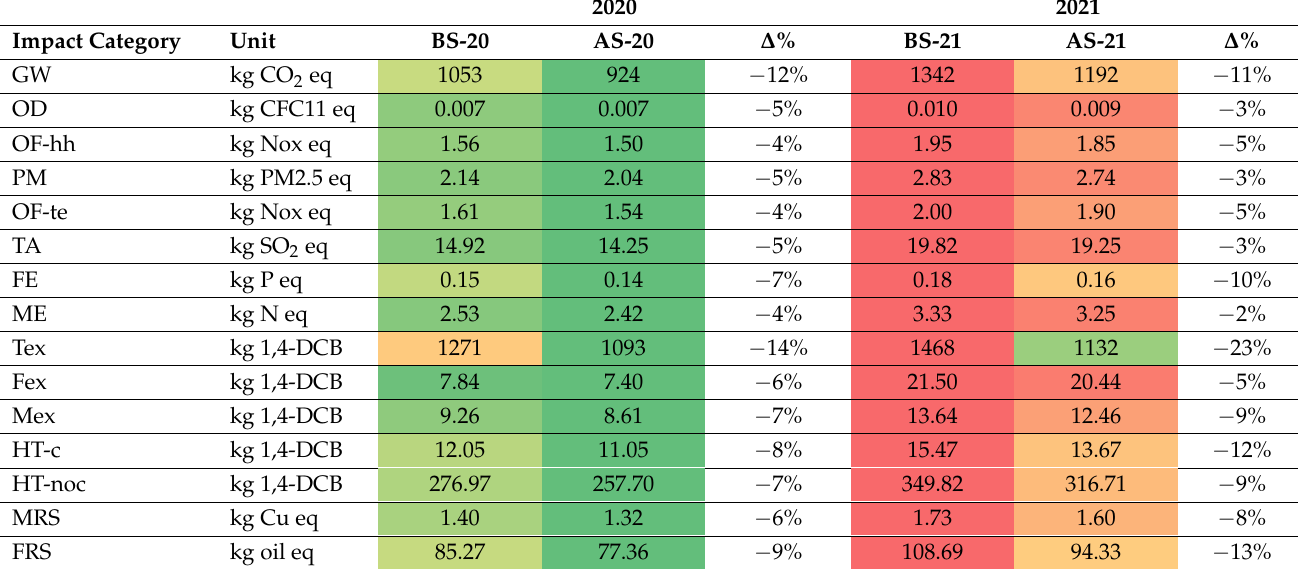
Table 3. Potential environmental impact for all scenarios evaluated. Higher values are highlighted in red; fro progressively lower impacts, it goes to orange-yellow and then